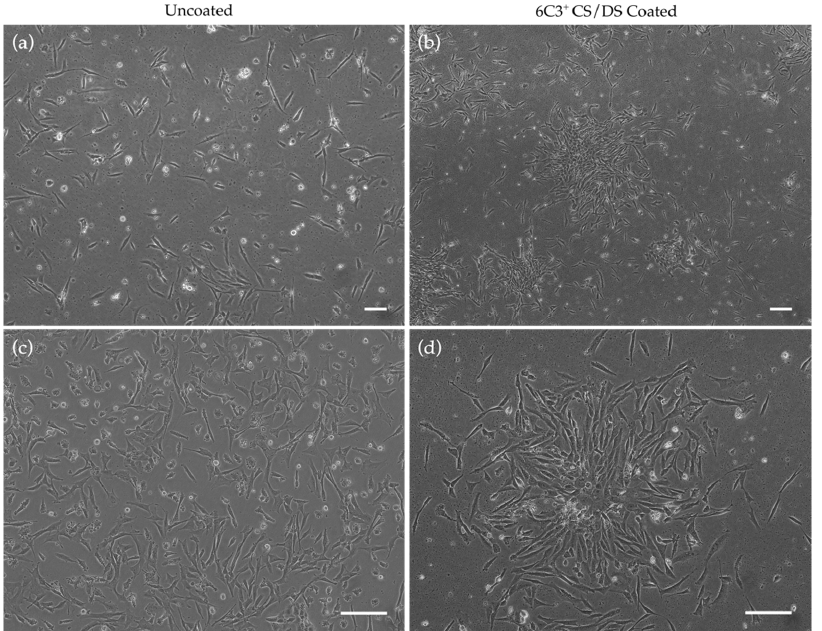
Figure 2. Phase contrast microscopy showing variation in growth pattern of E18 keratocytes cultured on uncoated and CS/DS coated substrate. ( a , c ) P0 cells cultured on uncoated dishes show diffuse